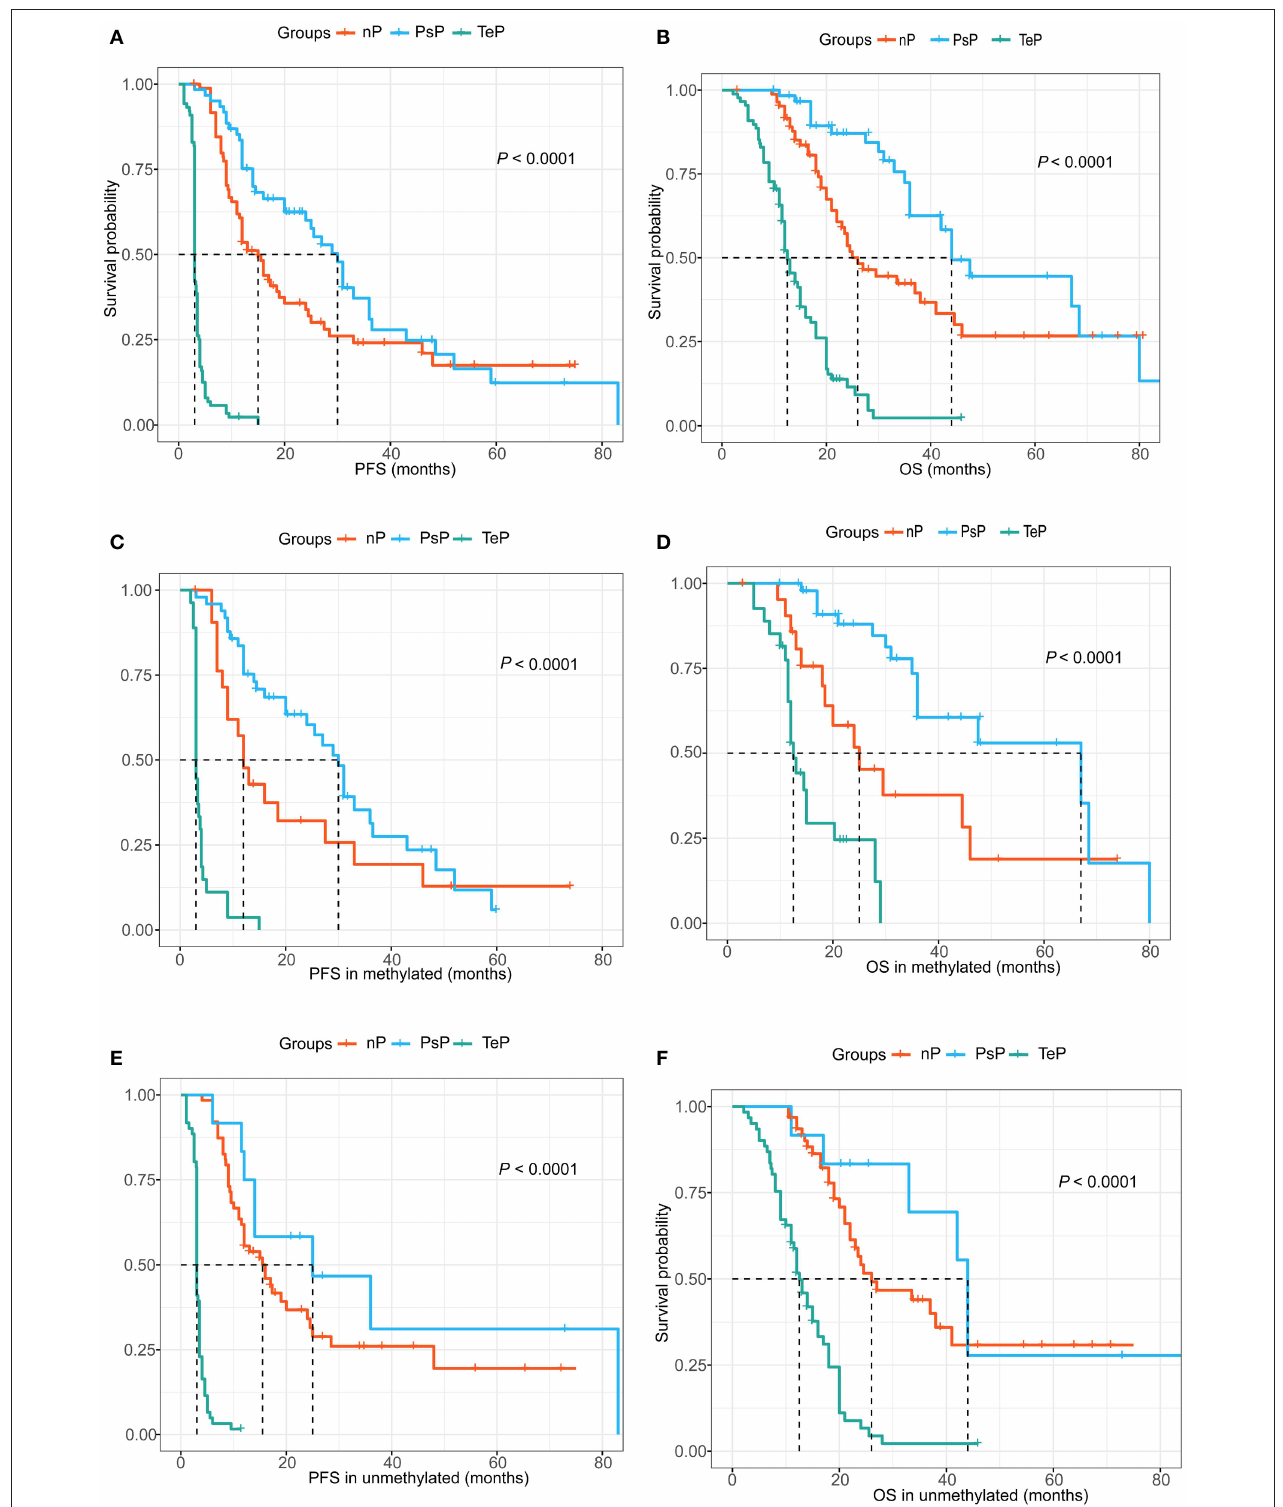
FIGURE 4 | (A,B) PsP demonstrated favorable progression-free survival (PFS) and overall survival (OS) compared with the TeP and neither patterns of progression (nP) subgroups. (C,D) Extended PFS and OS were observed in the MGMTp methylated subgroup for PsP patients. (E,F) Similar prognostic advantage was shown for PsP patients in MGMTp unmethylated